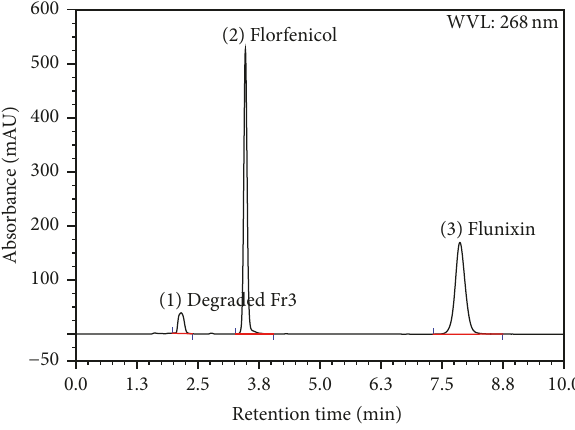
Figure4:ChromatogramofstresstestingofFlrandFlxunderacidic hydrolysis condition of 1N HCl, at 40 ∘ C for 2 days.